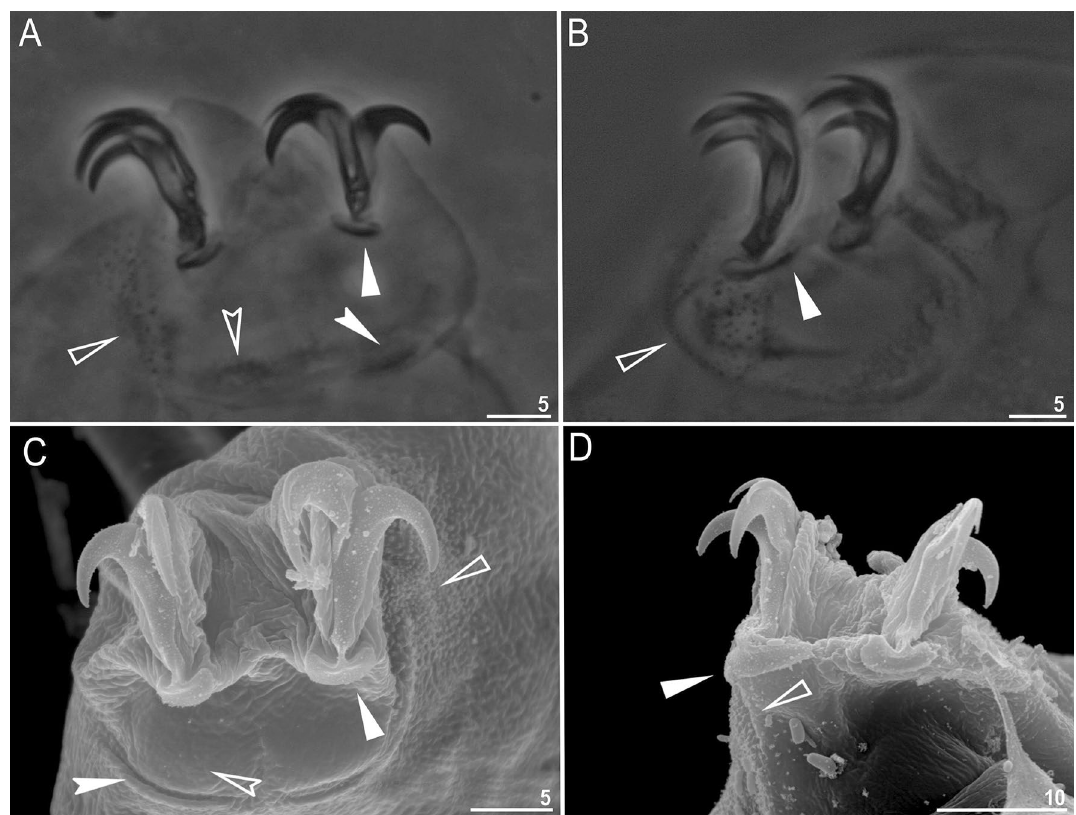
Figure 4. Paramacrobiotus gadabouti sp. nov.: ( A )—claws II (paratype, PCM); ( B )—claws IV (paratype, PCM); ( C )—claws II (paratype, SEM); ( D )—claws IV (paratype, SEM). Filled unindented arrowhead represents smooth lunulae, empty unindented arrowhead represents granulation, empty indented arrowheads represent single continuous bar and filled indented arrowheads represent doubled muscle attachments. Scale bars in gibbosities, papillae, pores, spines or sculpturing. The leg granulation is present on the external surface of legs I–III and on lateral and dorsal surfaces of the hind legs (Fig. 4A–D). Claws of the hufelandi type, stout (Fig. 4A–D). Primary branches with distinct accessory points. Smooth lunulae present under all claws (Fig. 4A–D, filled unindented arrowhead). Single continuous cuticular bar constricted in the middle and paired muscle attachments below claws I–III present (Fig. 4A–D, empty indented arrowhead and filled indented arrowhead). Bucco-pharyngeal apparatus of the Macrobiotus type (Fig. 5A–C), with ventral lamina and ten peribuccal lamellae (Fig. 6A). Mouth antero-ventral. The OCA is composed of three bands of teeth (similar on dorsal and ventral sides) (Figs. 5D–E and 6A–C). The first band of teeth consists of small cones (granules in PCM) situated at the anterior portion of the oral cavity, and just behind the base of the peribuccal lamellae (4–5 rows) (Figs. 5D, 6B, filled arrow). The second band of teeth positioned in the rear of the oral cavity between the ring fold and the third band of teeth (Figs. 5D, 6B, empty arrow) and composed of larger cones (small ridges parallel to the main axis of the buccal tube in PCM), arranged in one row that runs around the oral cavity wall (Figs. 5D–E and 6B, filled unindented arrowhead). The third band of teeth positioned just before the buccal tube opening and composed of dorsal and ventral portion (Figs. 5D–E and 6B–C). The dorsal portion of the third band comprises three, distinctly separated, long and thin ridges (Fig. 5D and 6C). Similarlty, the ventral portion is composed of three distinct teeth with two ventro-lateral onces in shape of ridges and one medio-ventral tooth being often divided into 2–3 smaller granular teeth (Fig. 5E). Additional teeth absent (Figs. 5D–E and 6A–C). Pharyngeal bulb spherical, with triangular apophyses and three rod-shaped macroplacoids. Macroplacoid length sequence 2 < 1 < 3 (Fig. 5A–C). The first macroplacoid without constrictions, but distinctly narrower anteriorly. The sec- ond macroplacoid of uniform width and without constrictions. The third macroplacoid with a sub-terminal constriction (Fig. 5A–B; empty unindented arrowhead). Microplacoid present, triangular in shape (Fig. 5A–B). Eggs: Laid freely, white, spherical exhibiting ornamentations of the richtersi type (Fig. 7A–B). Processes in the shape of rounded or truncated cones (Fig. 7A–F). Top endings of the processes with cap like structures (well visible in PCM in the process midsection and always well visible in SEM) (Fig. 7D–F). The surface of cap-like structrues is mostly rough with small granules and wrinkles that can be visible on its surface but only in SEM (Fig. 7D, F). Labyrinthine layer between process walls visible under PCM as a clear reticular pattern (Fig. 7C). Reticular pattern composed of regular and elongated mesh with straight or slightly sinuous margins. Egg shells areolated with a single ring of 10–12 areolae around each process (Fig. 7C–D). Internal surface of areolae clearly sculptured in PCM and pores that are visible only in SEM (Fig. 7C–D).